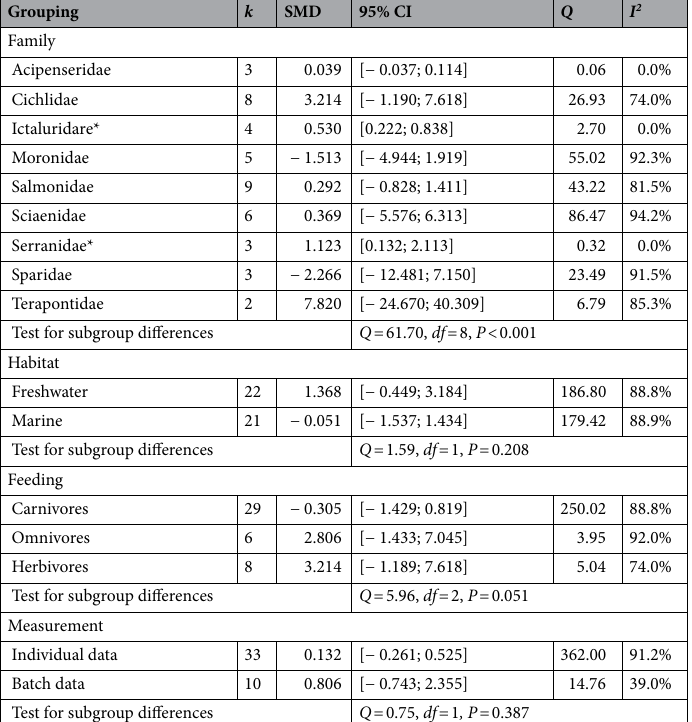
Table 4. Sources of heterogeneity and subgroup analysis in the Schizochytrium dataset according to a random effects model. Groups that display a positive effect of Schizochytrium on omega-3 content in the fish fillet are denoted by an asterisk. k number of studies, SMD standardized mean difference compared to controls, 95% CI 95% confidence interval around SMD, Q Cochran’s measure of heterogeneity. I 2 percentage of variability unaccounted by sampling